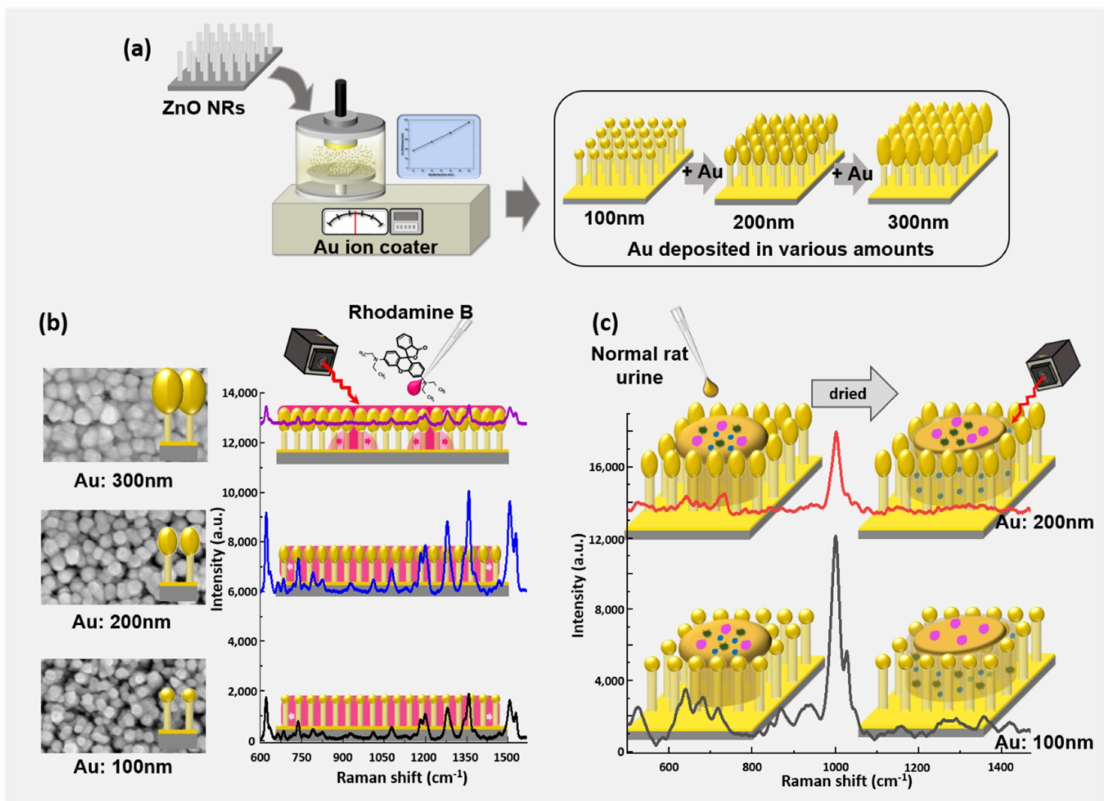
Figure 1. Schematic showing the processes of the ZnO nanorod-based surface-enhanced Raman scattering (SERS) substrate. ( a ) Au coated substrate production, ( b ) optimization of application, and ( c ) measurement of rat